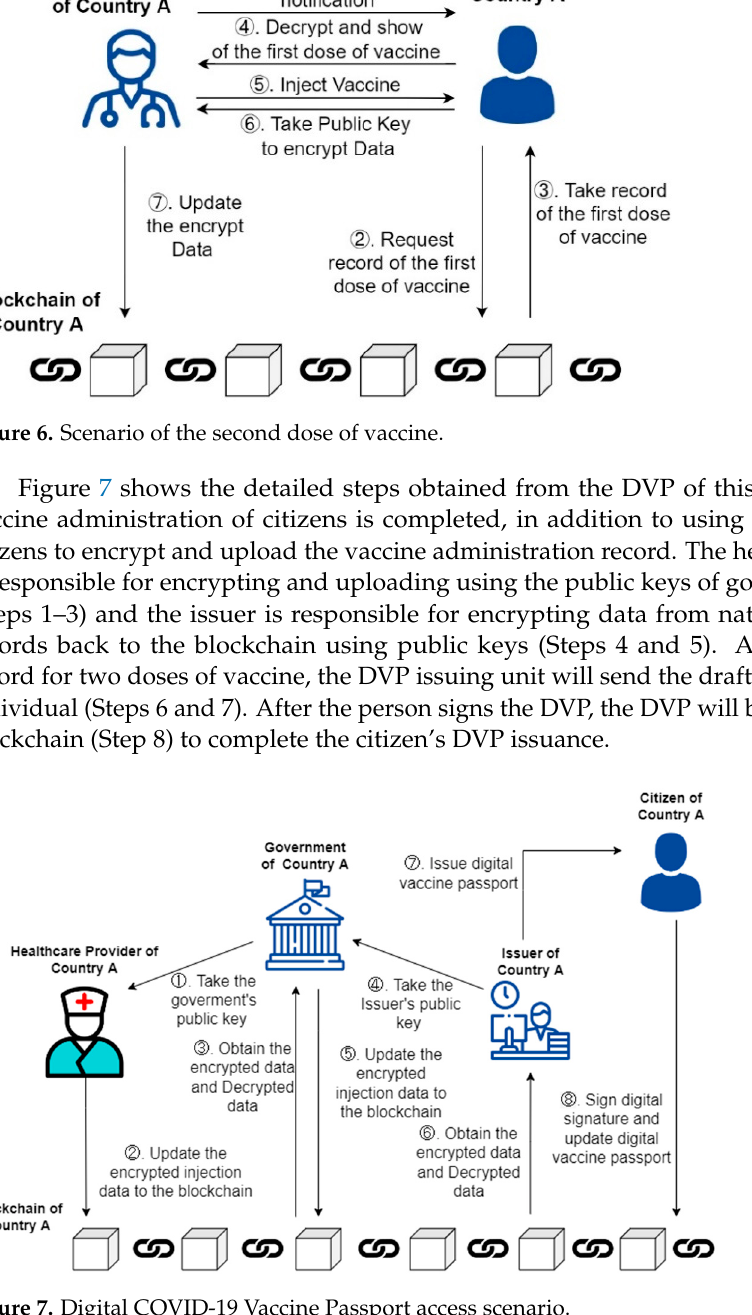
Figure 7. Digital COVID-19 Vaccine Passport access scenario.